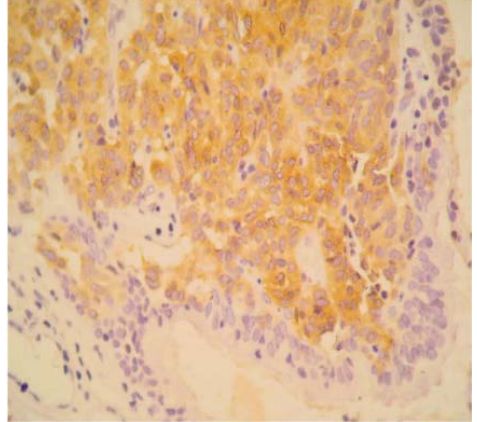
Figure 5 - Neuron-specific enolase expression (40x)